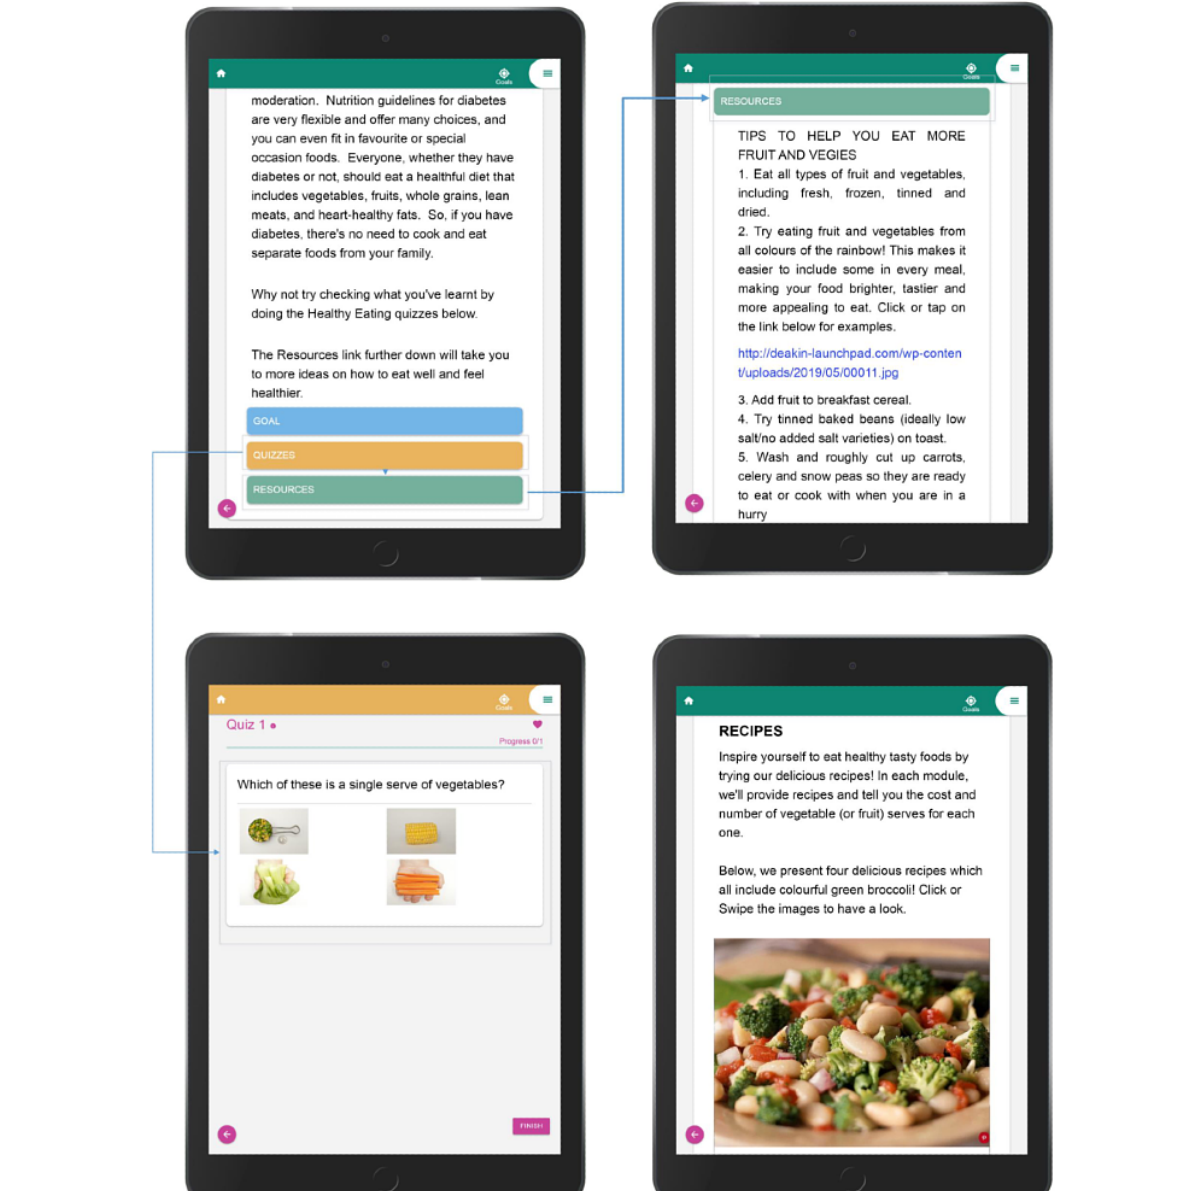
Figure 2. Screenshots of different parts of